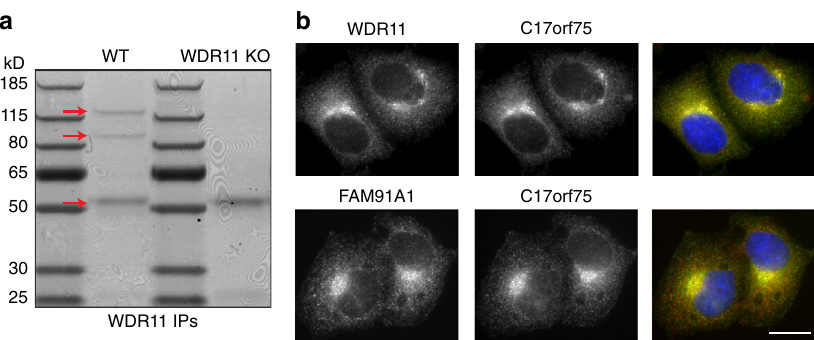
Fig. 2 Identi fi cation of the WDR11 complex. a Extracts from wild-type and WDR11-knockout cells were immunoprecipitated with anti-WDR11, and precipitating proteins were identi fi ed by mass spectrometry. The arrows on the Coomassie blue-stained gel indicate, from top to bottom, WDR11, FAM91A1, and C17orf75 (running close to the IgG heavy chain band). b HeLa cells were double labelled for either WDR11 (green) and C17orf75 (red), or FAM91A1 (red) and C17orf75 (green). The proteins have virtually identical localisation patterns. Scale bar: 20 µ